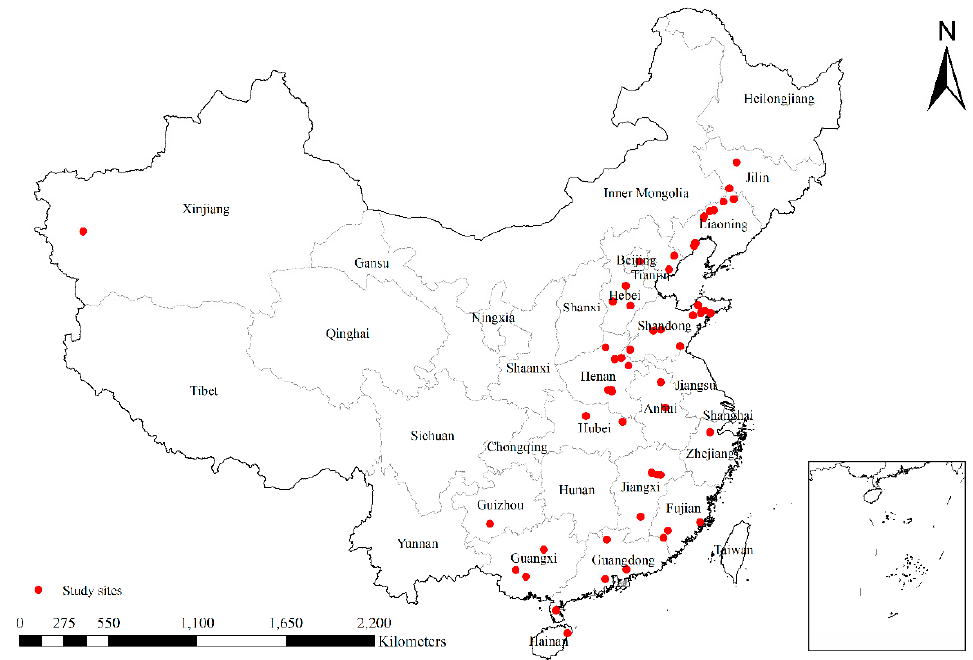
Figure 1. Distribution of experimental plots for peanut in China.